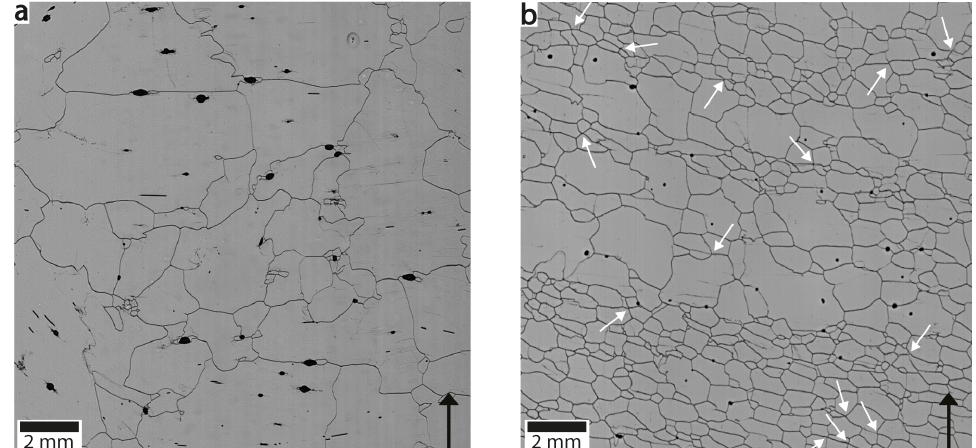
Figure 2. Reflected LM images of ice core sections at (a) 921m depth in the Holocene ice and (b) 1977m depth in the Glacial ice of the NEEM ice core. The black arrows indicate the top of the ice core. The Glacial ice core section contains layers with coarse and relatively fine grains that are distributed in subhorizontal bands. These fine-grained subhorizontal bands have many aligned grain boundaries and quadruple junctions that are indicated by white arrows. Images taken from Kipfstuhl (2010) (https://doi.pangaea.de/10.1594/PANGAEA.743296).